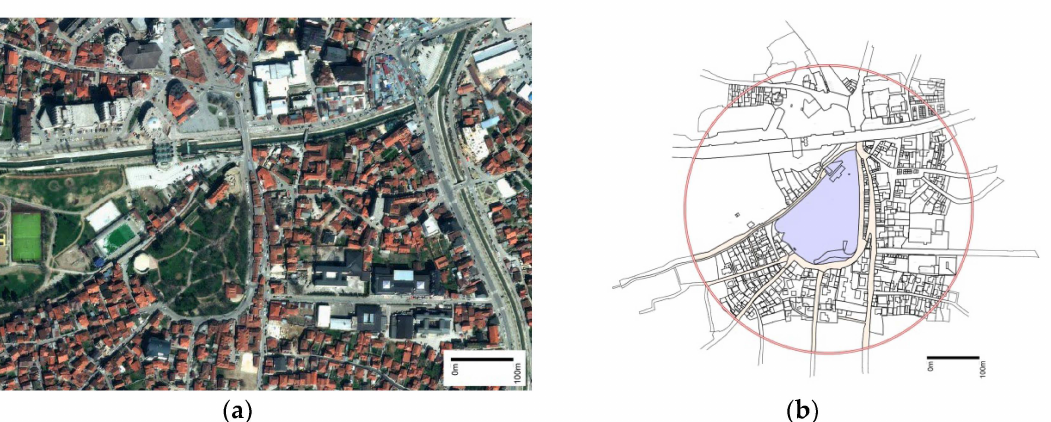
Figure 1. Aerial view of the City Fortress. ( a ) Position of the fortress in Novi Pazar (photo source Geo Serbia); ( b ) City Fortress (drawing design: Lejla Ze´cirovi´c).